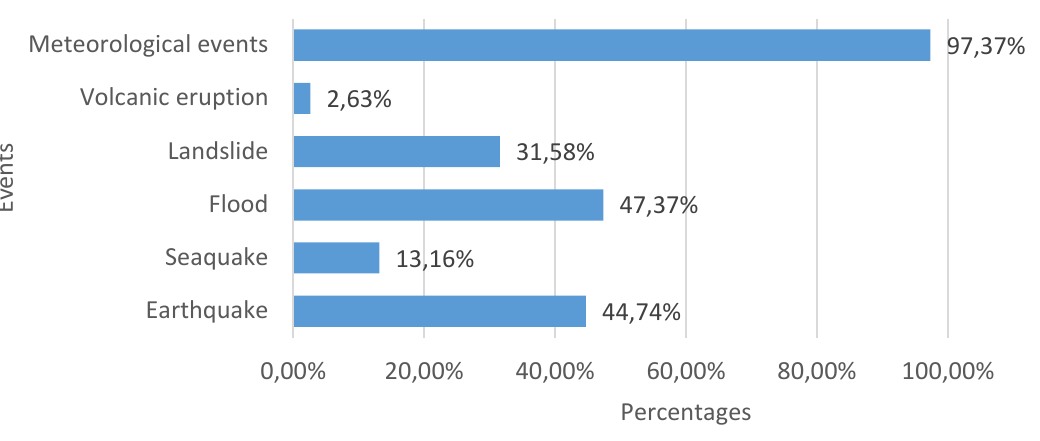
Figure 3. Insured events